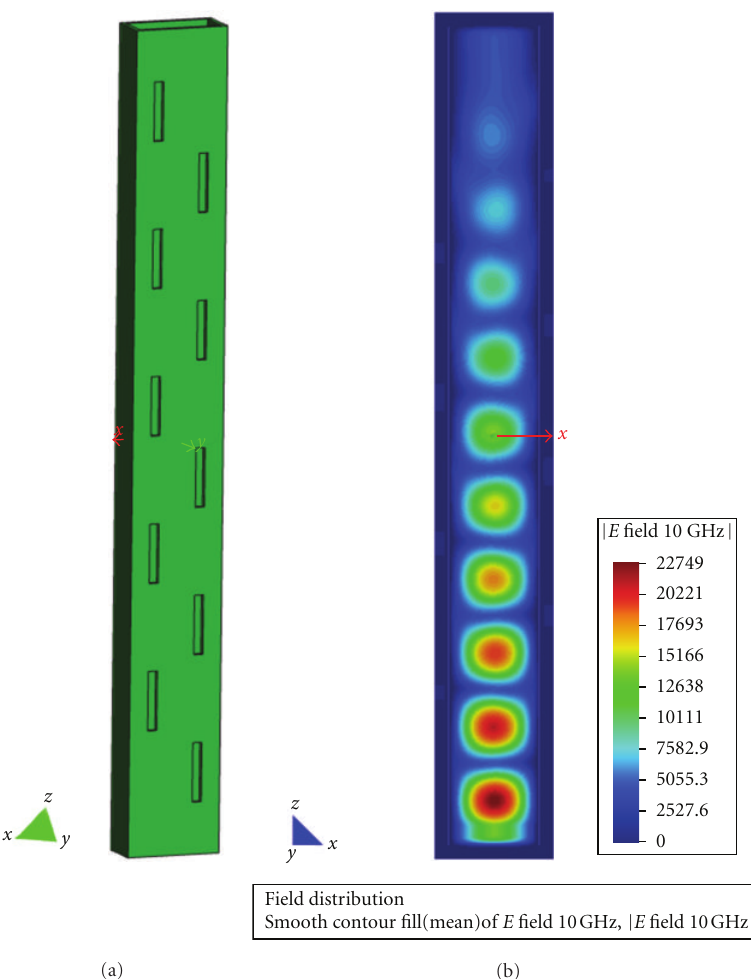
Figure 5: (a) Model of the waveguide with ten slots; (b) smooth contour fill of E field distribution of the x o z plane.